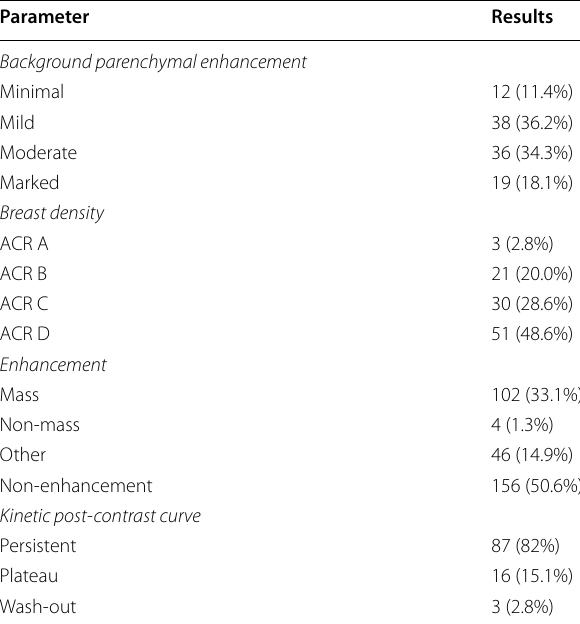
Table 3 Main characteristics of MRI findings Parameter Results